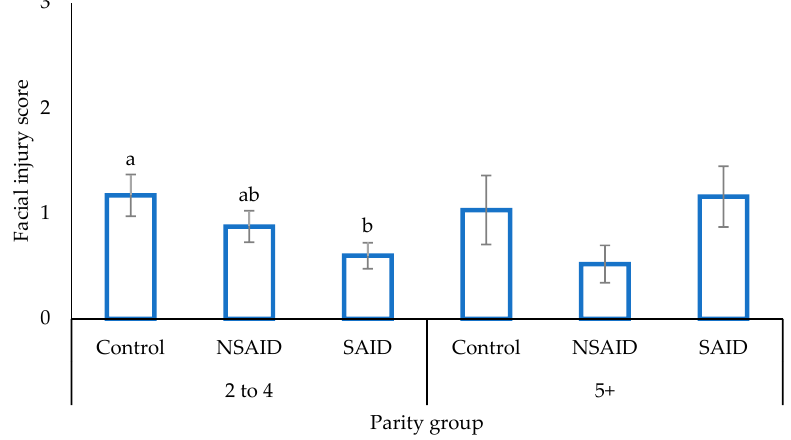
Figure 2. The mean ± SEM facial injury score (with 0 being no injury, and 3 being a high level of injury) for sows of parity 2 to 4 or 5+ injected with either saline (Control), a non-steroidal anti- inflammatory (NSAID), or a steroidal anti-inflammatory (SAID) prior to farrowing. a,b represents a significant difference ( p < 0.05) within parity group.